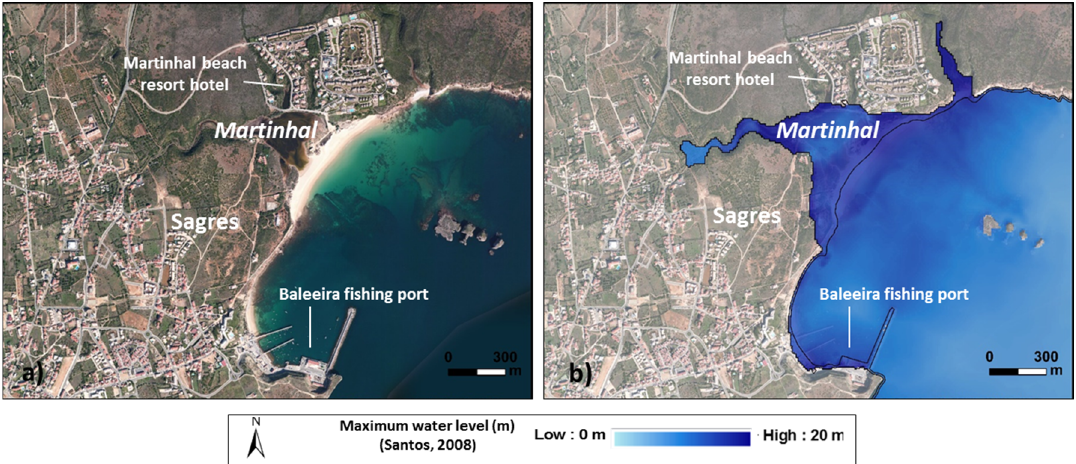
Figure 3. Martinhal study area: ( a ) Satellite image from study area; ( b ) Tsunami inundation from numerical model results for Martinhal